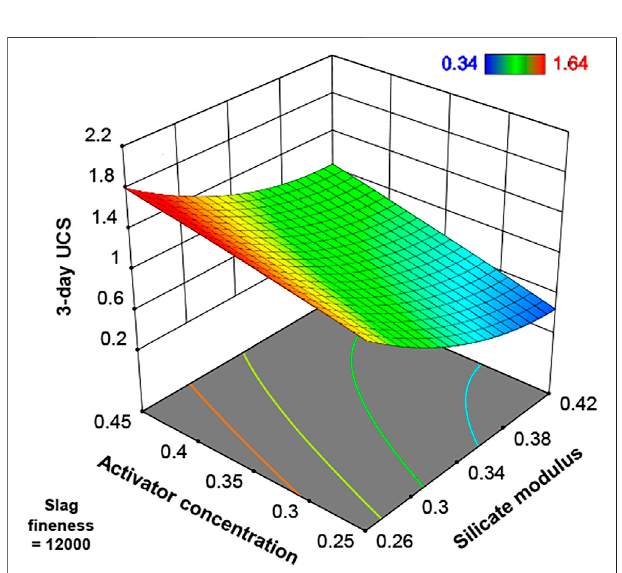
FIGURE 6 | Response-surface of the in fl uence of slag fi neness and its interaction with silicate modulus at a fi xed activator concentration of 0.35. FIGURE7| Response-surfaceofthein fl uenceofsilicatemodulusandits